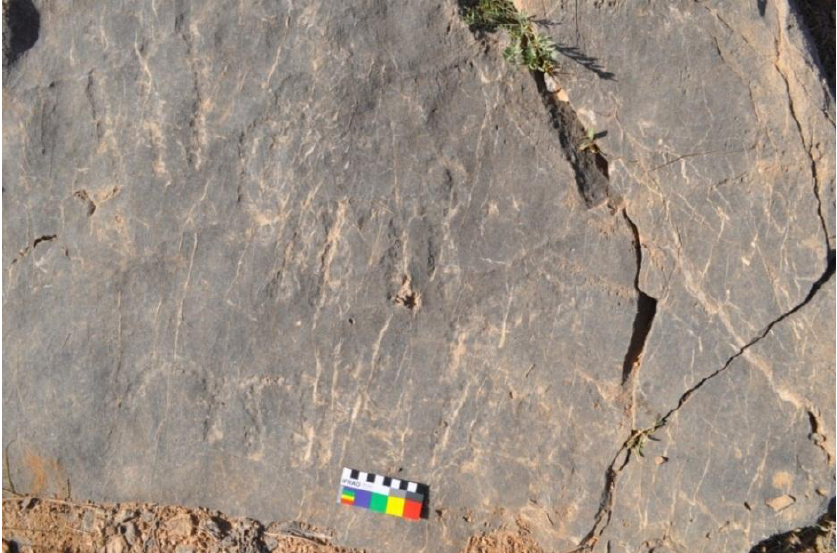
Figure 4. Ghārā-Tepe I, panel 2, zoomorphs and geometric